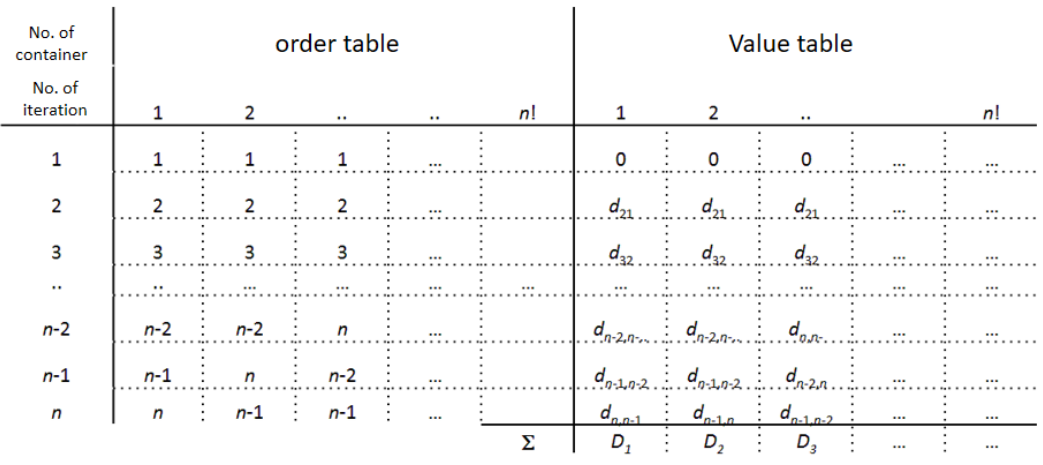
Figure 3. View of the sheet containing the table of results.